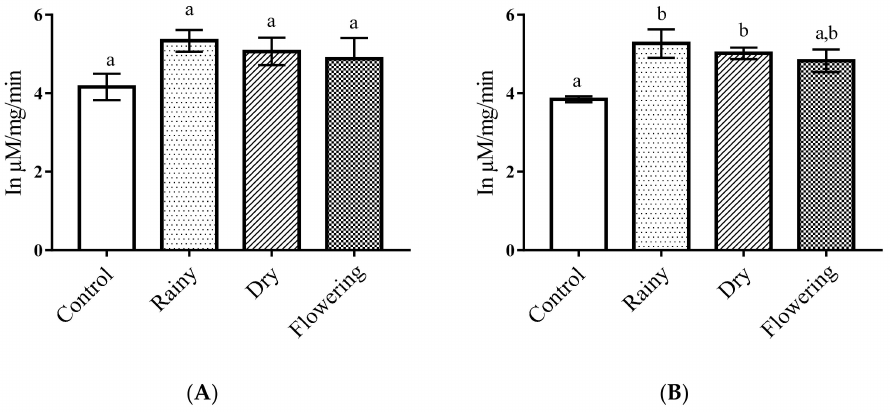
Figure 6. Biochemical changes in esterases of Ae . aegypti and Ae . albopictus larvae. Changes in esterase levels between Ae . aegypti ( A ) and Ae . albopictus ( B ) larvae treated and not treated with the essential oils of Lippia grata . Different lowercase letters in the bar denote significant difference ( p < 0.05). Bars represent standard deviations ( n = 3). Values estimated by one-way ANOVA followed by the Tukey test. Control, untreated